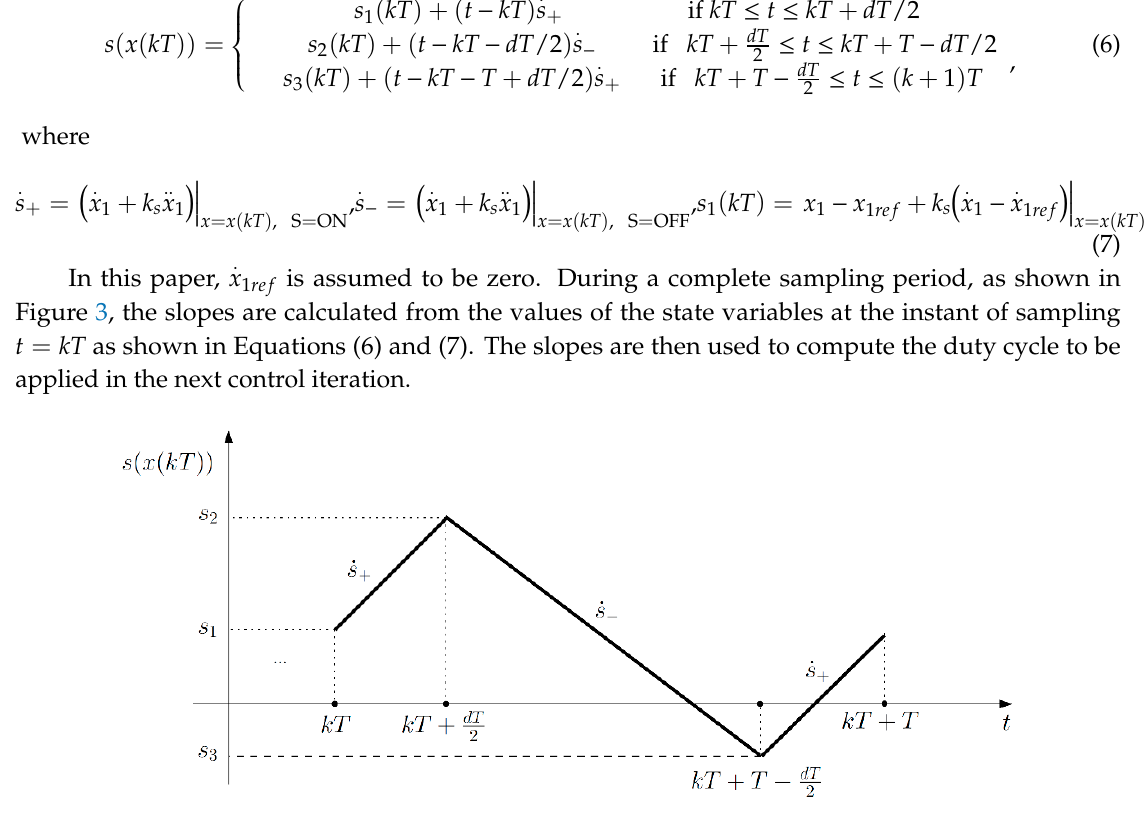
Figure 3. Piecewise description of the sliding surface in a complete period considering the commutation events generated by a CPWM signal of duty cycle 𝑑 and period 𝑇 .